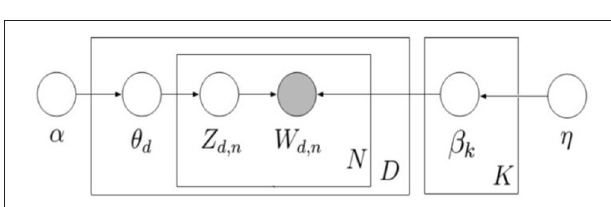
FIGURE 2 | Graphical model representation of LDA (Blei et al., 2003).